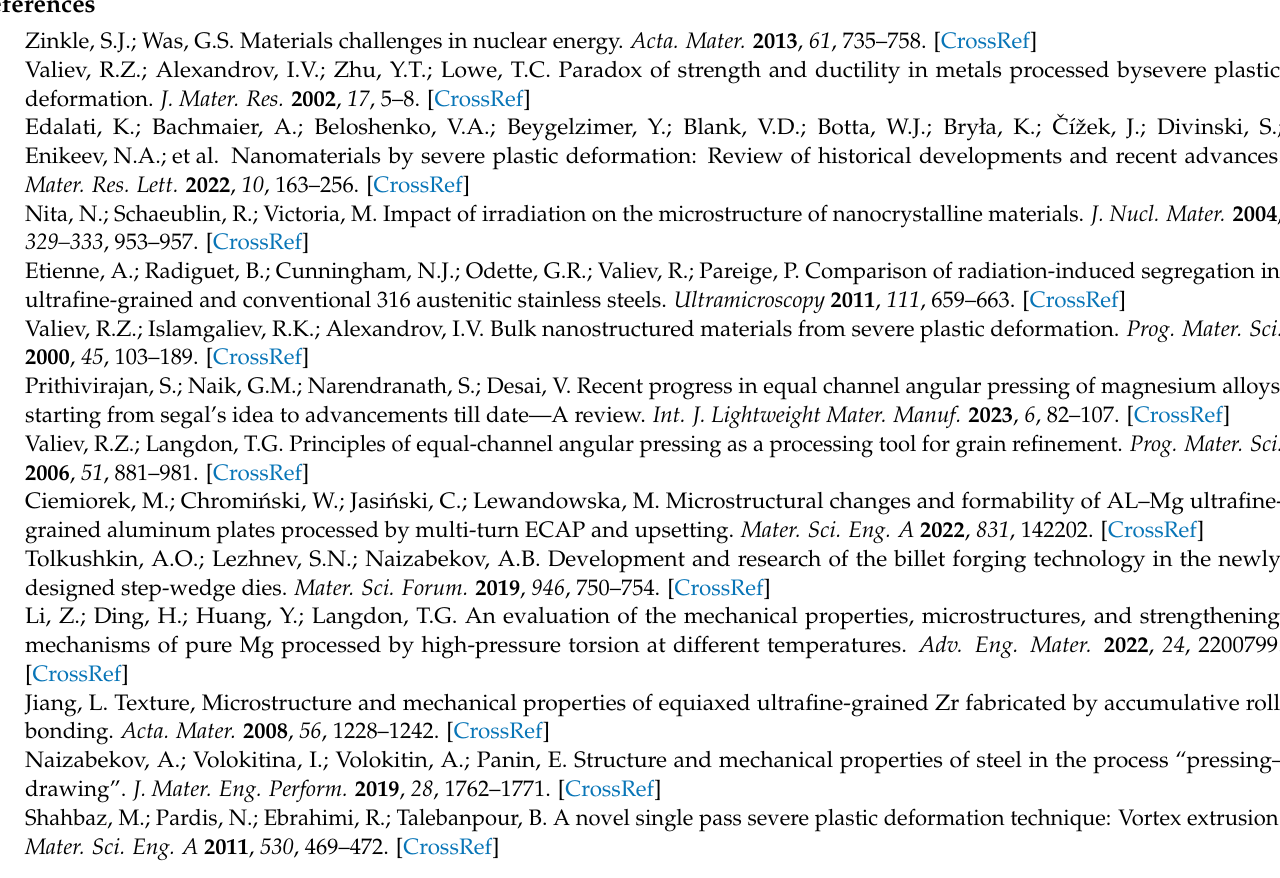
Figure S6: 5 mm distance from the center, Figure S7: 6 mm distance from the center, Figure S8: INITIAL Structure by EBSD, Figure S9: INITIAL Structure by TEM, Figure S10: EBSD legend IPF 1